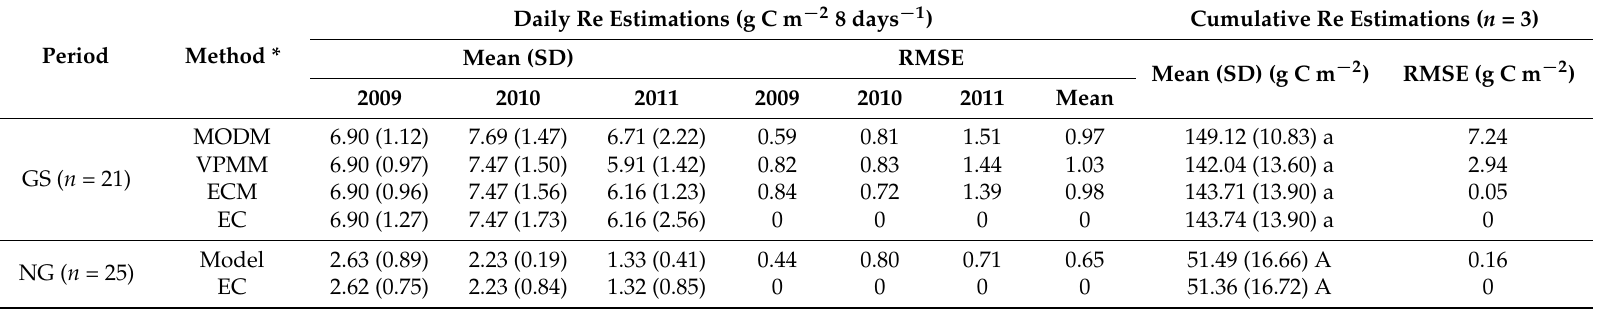
Table 3. Satellite-based ecosystem respiration (Re) estimations and comparison with eddy-covariance (EC) tower-based Re observation from 2009 to 2011.